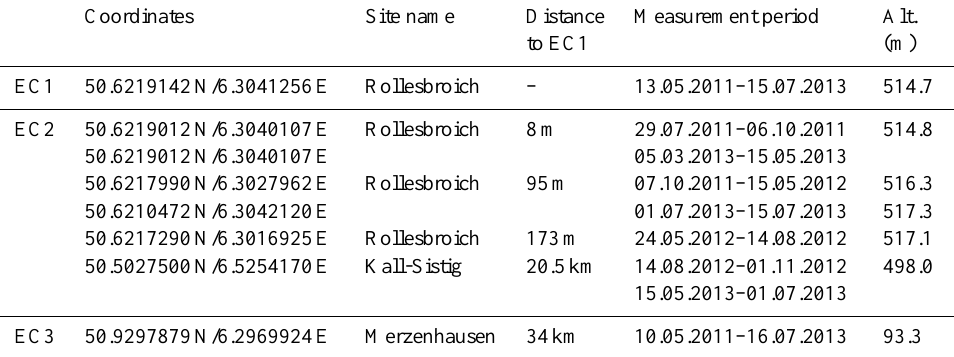
Table 1. Measurement periods and locations of the permanent EC towers in Rollesbroich (EC1) and Merzenhausen (EC3) and the roving station